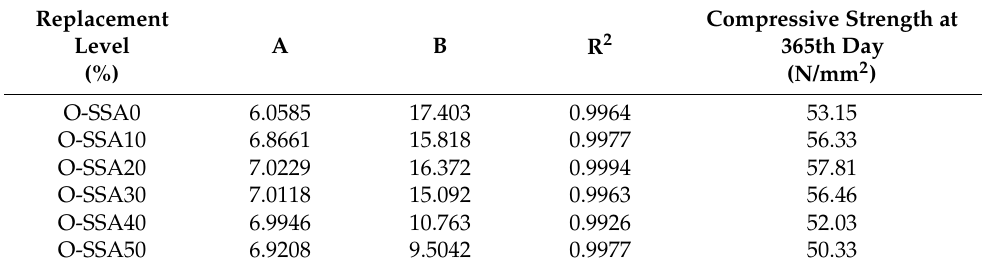
Figure 14. Compressive strength data vs. time (days). Table 7. Values of A, B, R 2 , and compressive strength at the 365th day with respect to a different replacement level.